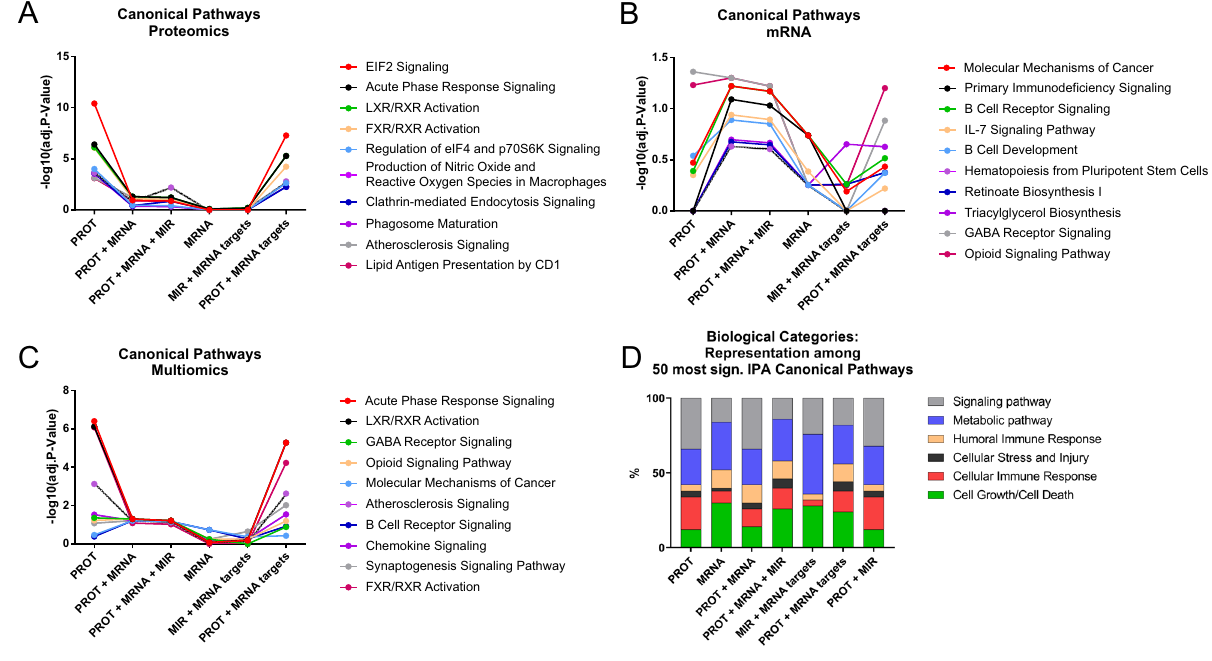
Figure 2. Different omics analyses result in different pathway signatures. Adjusted p- values of the 10 pathways with highest significance in the respective analyses were comparatively evaluated. Statistical significance is reached at − log10(adj. p- value) > 1.3 (i.e., adj. p- value < 0.05). We compared the pathway analysis results of the ten pathways with the lowest adjusted p- values from: ( A ) proteomics alone (PROT), ( B ) mRNA-seq alone (MRNA), and ( C ) multiomics analysis (PROT + MRNA + MIR). The large differences in adjusted p- value differences between PROT and MRNA in A and B are consistent with very disparate results for their respective pathway signature. ( D ) Percentages of the biological categories attributed to the 50 most significantly affected pathways captured by proteomics, mRNA, and miRNA or their